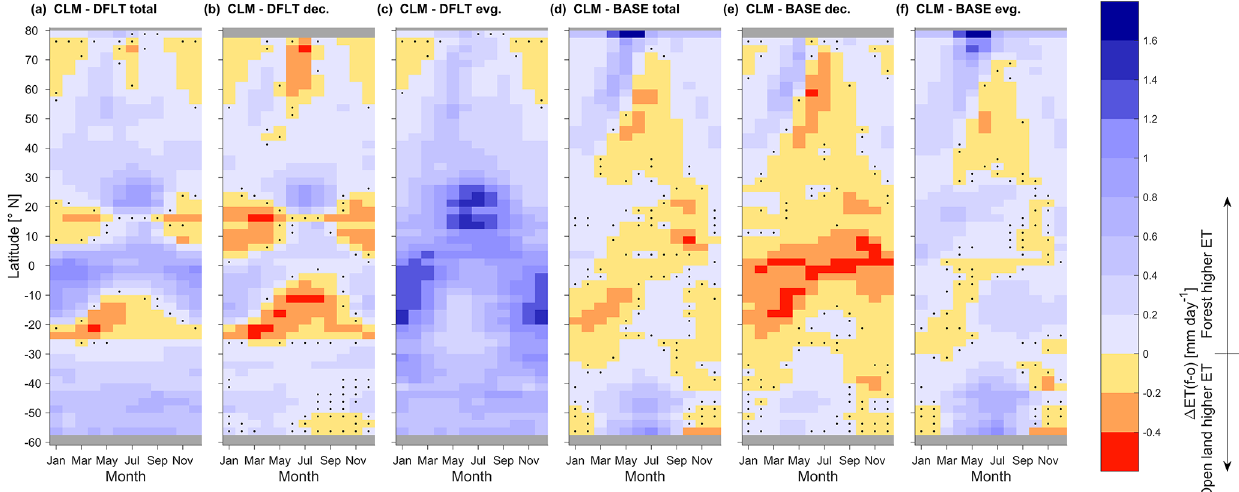
Figure A8. Seasonal and latitudinal variations of (cid:49) ET (f − o) in CLM-DFLT for (a) all tree PFTs minus open land, (b) deciduous tree PFTs only minus open land, and (c) evergreen tree PFTs only minus open land. Points with a mean which is insignificantly different from zero in a two-sided t test at 95% confidence level are marked with a black dot. All data from the 2002–2010 analysis period corresponding to a given latitude and a given month are pooled to derive the sample set for the test. The same is done for CLM-BASE in panels (d) , (e) , and (f)